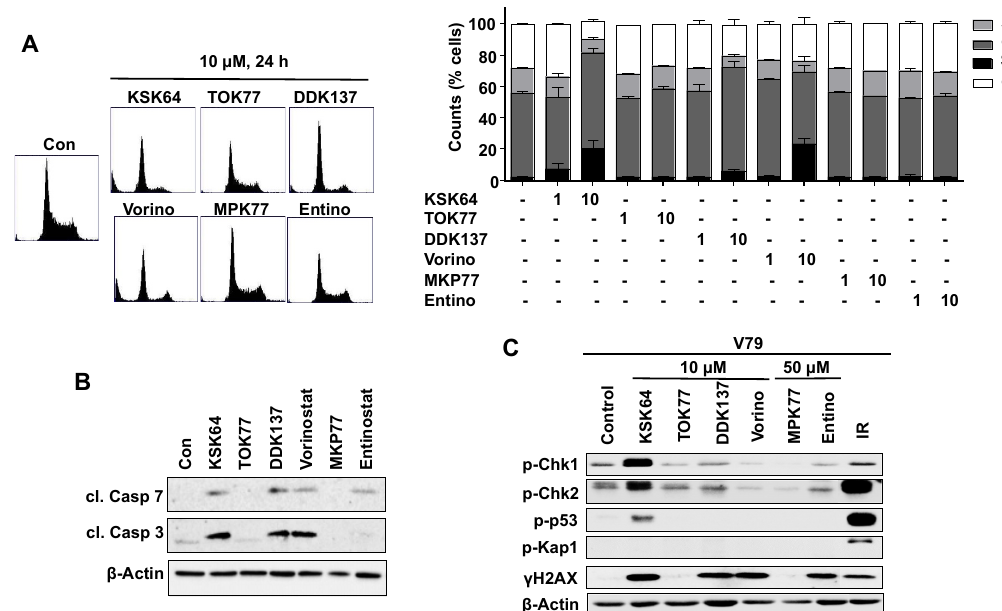
Figure 5. Influence of hydroxamic acid- and benzamide-type HDACi on the activation of cell death- and DDR-related mechanisms. ( A ) Cell cycle distribution was analyzed 24 h after the addition of hydroxamic acid- and benzamide-type HDACi to V79 cells, as described in Methods. In the left panel, representative data obtained from flow cytometry analysis are shown. On the right-hand side, the mean ± SD obtained from three independent experiments (n = 3) are shown. ( B ) Activation of caspase-mediated apoptotic death pathways was analyzed 24 h after treatment of V79 cells with 10 µM of the corresponding HDACi by Western blot analysis using antibodies that specifically detect the cleaved (i.e., activated) forms of caspase-7 (cl. Casp 7) and capase-3 (cl. Casp 3). The protein expression of beta-actin was used as protein-loading control. ( C ) The activation of selective factors of the DNA damage response (DDR) was analyzed by Western blot analysis of total cell extracts using phospho-specific antibodies as indicated. The protein expression of beta-actin was monitored for protein-loading